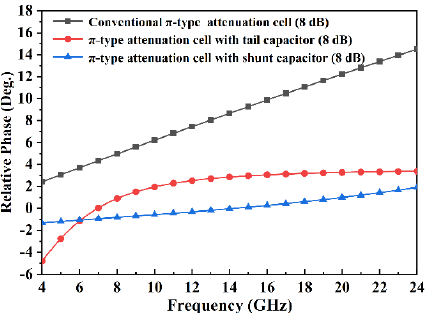
Figure 10. Comparison of the relative phase variation between the conventional attenuation and both of the improved π− type attenuations. of the improved π -type